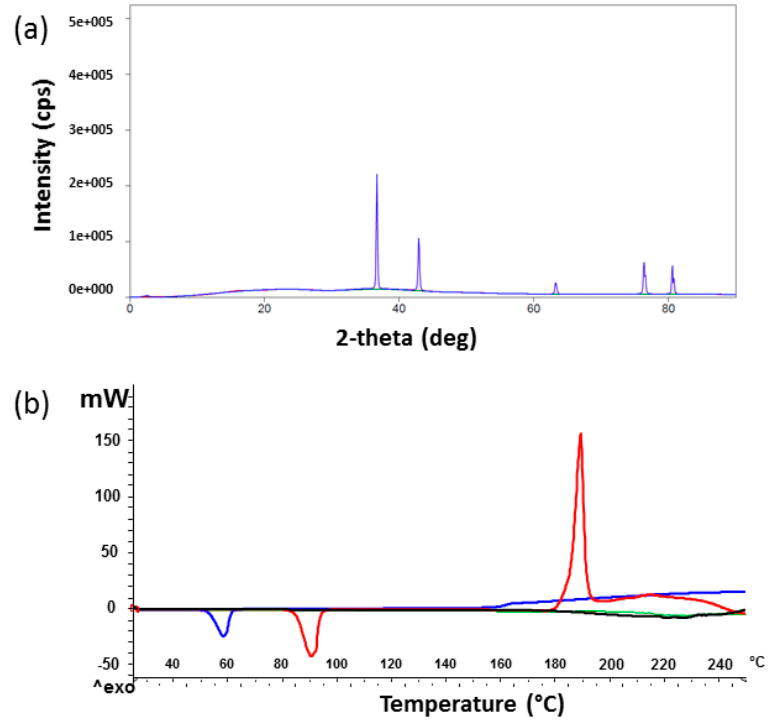
Figure 2. ( a ) XRD evaluation of the hydrogel, reflecting the crystalline nature of the copolymer and ( b ) DSC thermograms reflecting the hydrogel (black line), polyacrylamide (green line), acrylamide (red line) and pluronic F-127 (blue line) at a heating rate of 10 °C between the temperature range of 25–240 °C.